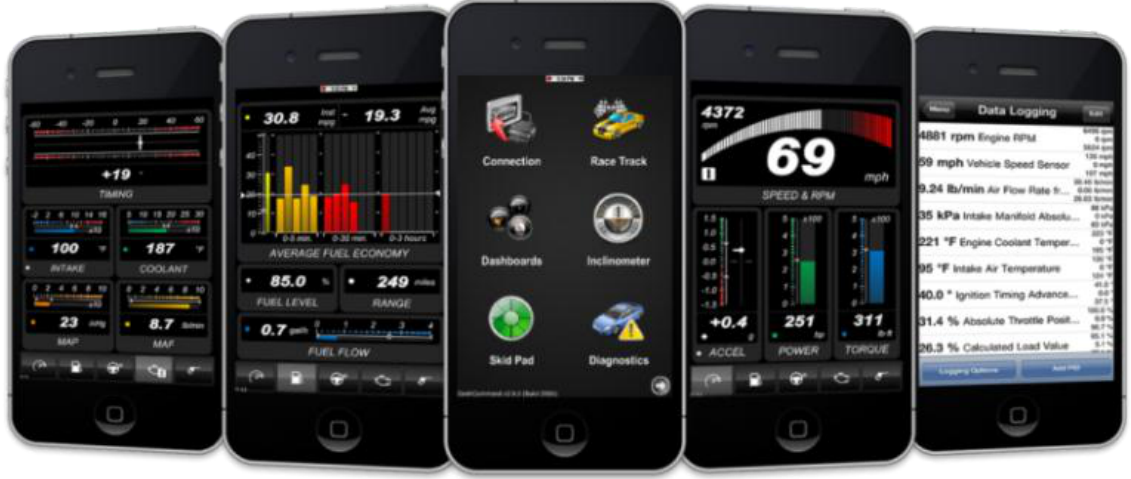
Figure 10. Vehicle Monitoring Apps. Image credit: PLX Devices